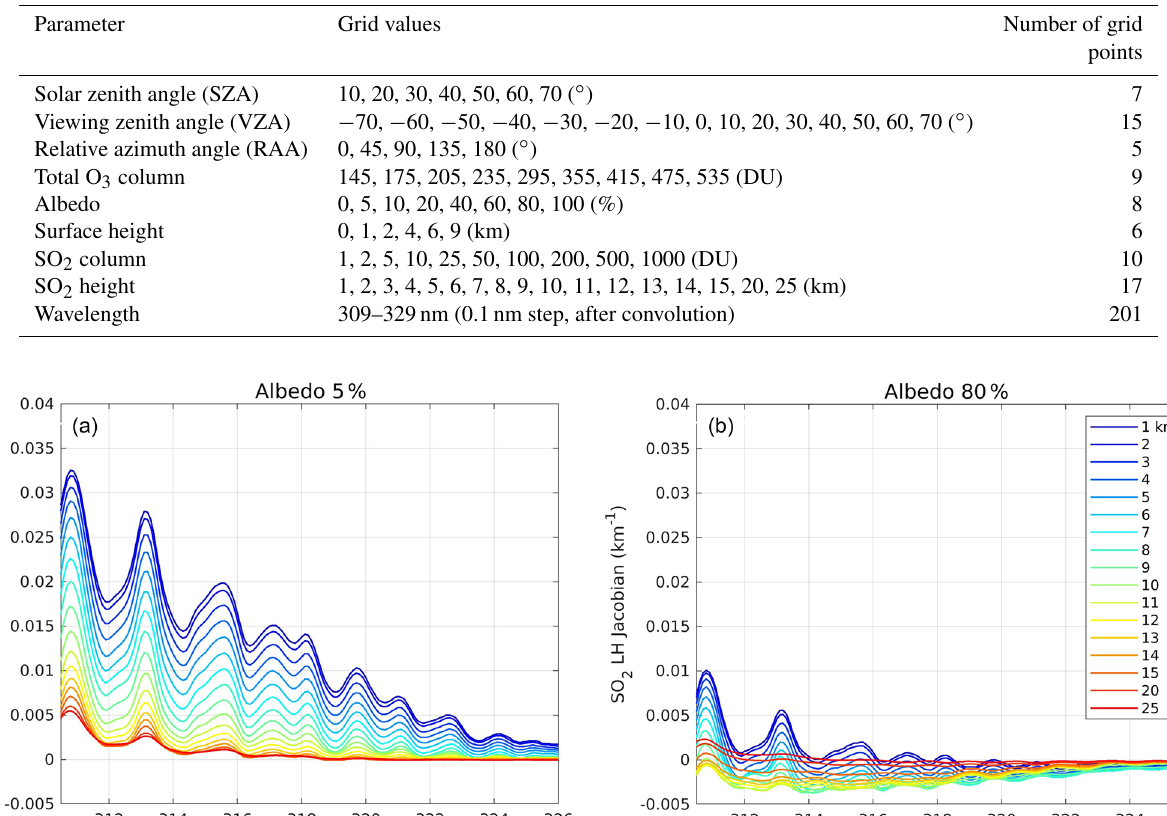
Table 1. Physical parameters that define the SO 2 slant optical depth look-up table. The total number of spectra is about 38 . 5 × 10 6 . In practice, note that the look-up table interpolation is performed along the cosine of SZA and VZA.